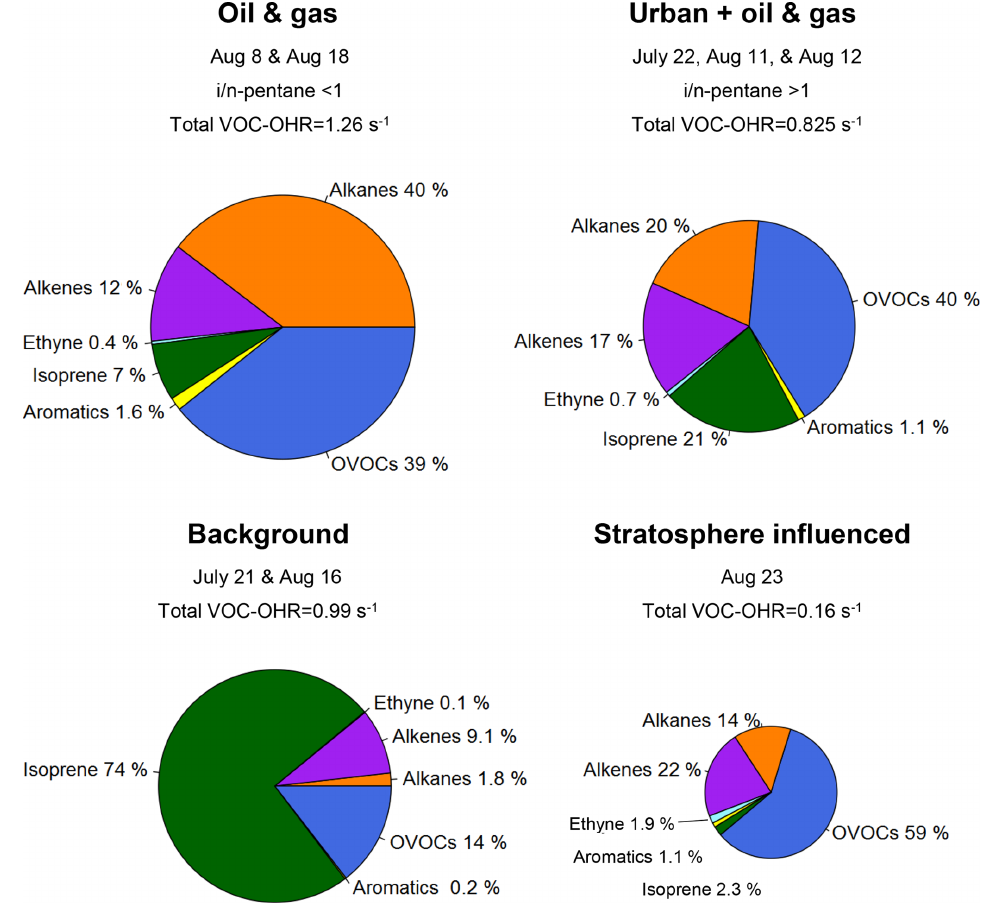
(cid:113) Figure 11. Contributions to VOC– OH reactivity (VOC-OHR) for the high-O 3 days for peak O 3 hours as shown in Table 2. Days with high O 3 were grouped by the ratio of i - to n -pentane for oil- and gas-influenced and urban-influenced air masses. Background days, defined by the lowest 10th percentile for ethane, and the stratospheric influenced period are used for comparison to the high-O 3 days resulting from anthropogenic activities. The size of each pie chart is proportional to the total VOC-OHR for the given type of air mass. Reactivity was calculated using rate constants from Atkinson and Avery (2003) and Atkinson